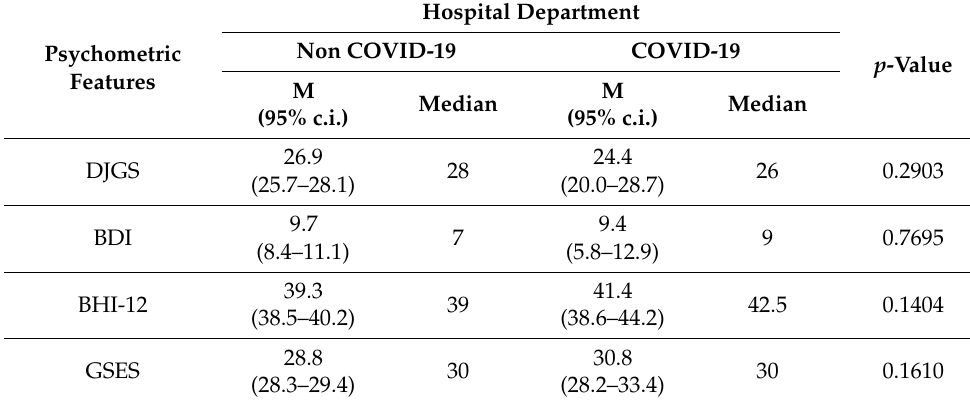
Table 7. Correlations between the applied psychometric scales and the place of residence.